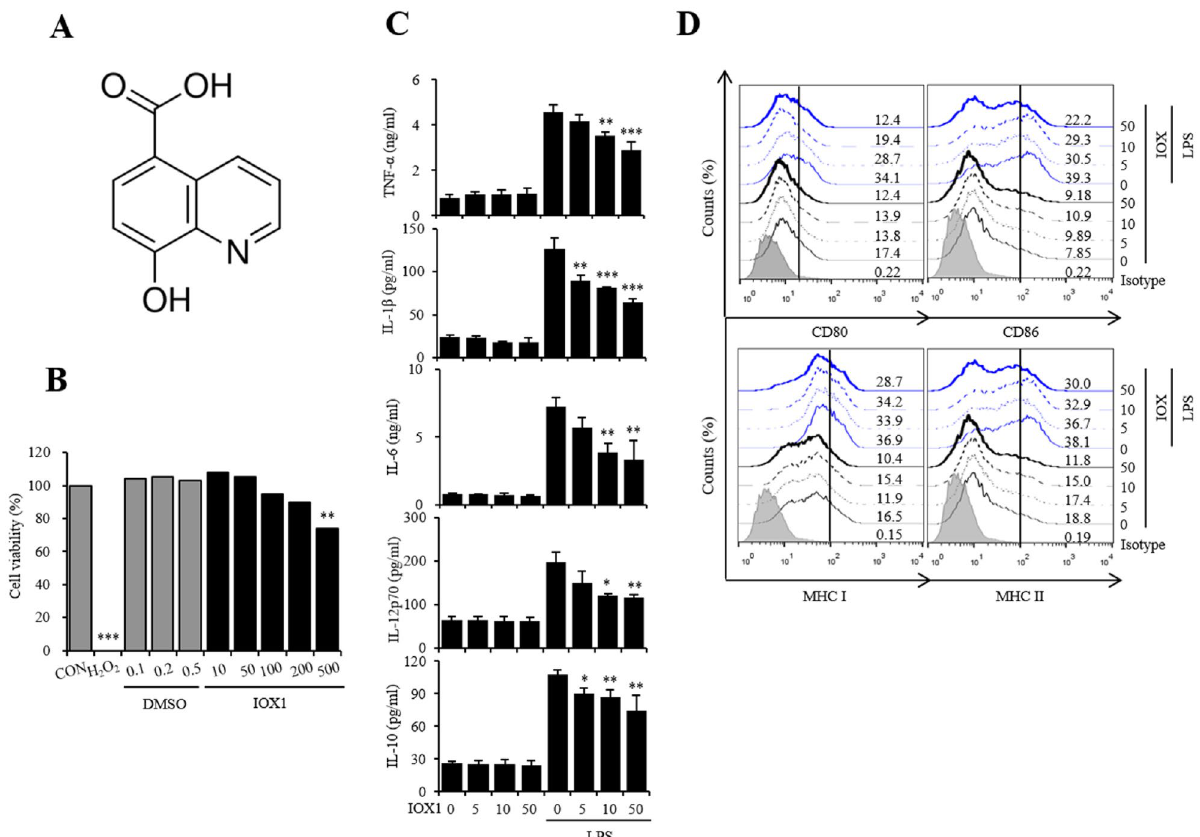
Figure 1. IOX1 suppresses the inflammatory response in LPS-induced DC maturation. ( A ) Chemical structure of IOX1. ( B ) Mouse bone marrow-derived DCs were treated with the indicated concentrations of IOX1, DMSO or H 2 O 2 (negative control) overnight. The cytotoxicity of IOX1 in DCs was analyzed by a Luminescent Cell Viability Kit. ( C ) DCs treated with IOX1 (50 μM) before or after LPS stimulation (50 ng/ml) at the